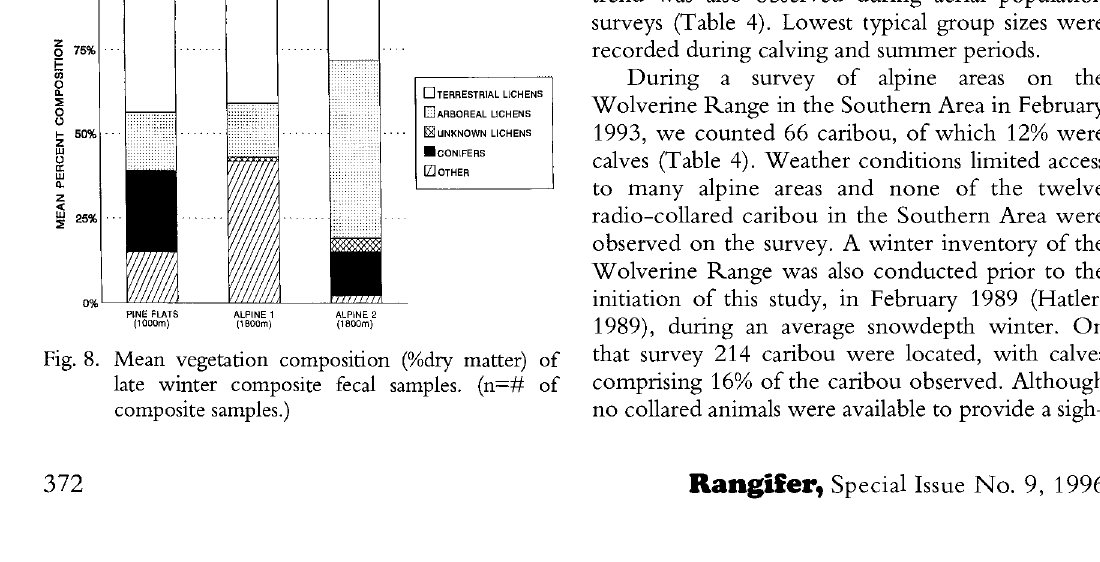
Fig- Mean vegetation composition (%dry matter) of late winter composite fecal samples. (n=# of composite